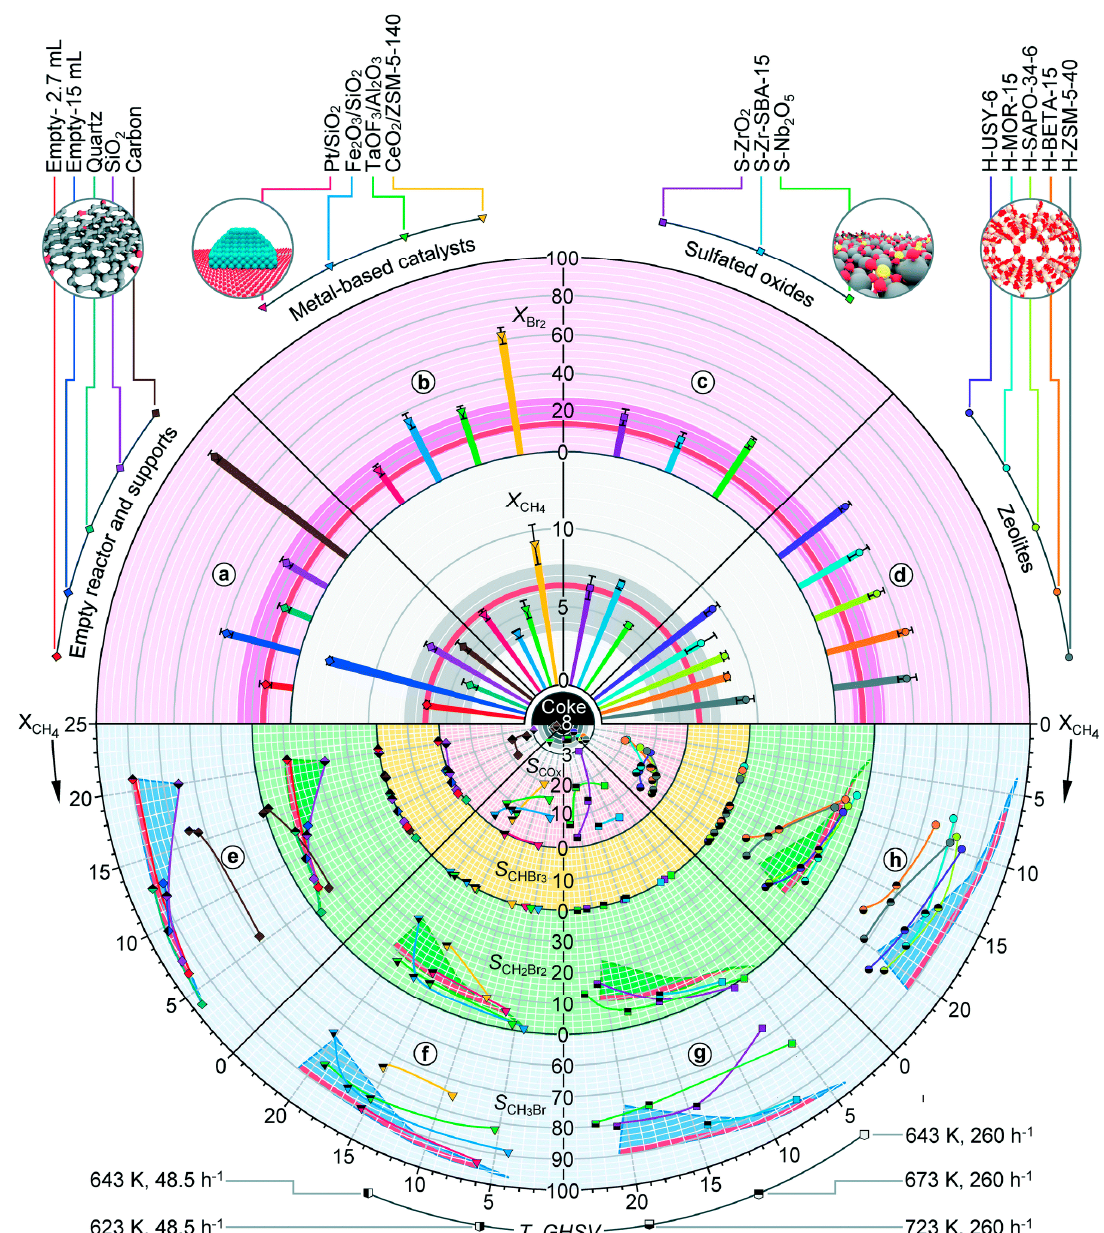
Figure 1. Methane bromination reactions at T = 643 K and GHSV (gas hourly space velocity) = 260 h − 1 ( a ) in empty reactors and over supports, ( b ) supported metal-based catalysts, ( c ) sulfated oxides, and ( d ) zeolites. Selectivity to di ff erent products in methane bromination ( e ) in empty reactors and over supports, ( f ) supported metal-based catalysts, ( g ) sulfated oxides, and ( h ) zeolites as a function of methane conversion, which was adjusted by varying the temperature or GHSV. Conversions and selectivities are expressed in %. Other conditions: CH 4 /Br 2 = 8.5/3.2 ± 0.1 and P = 100 kPa. Reprinted